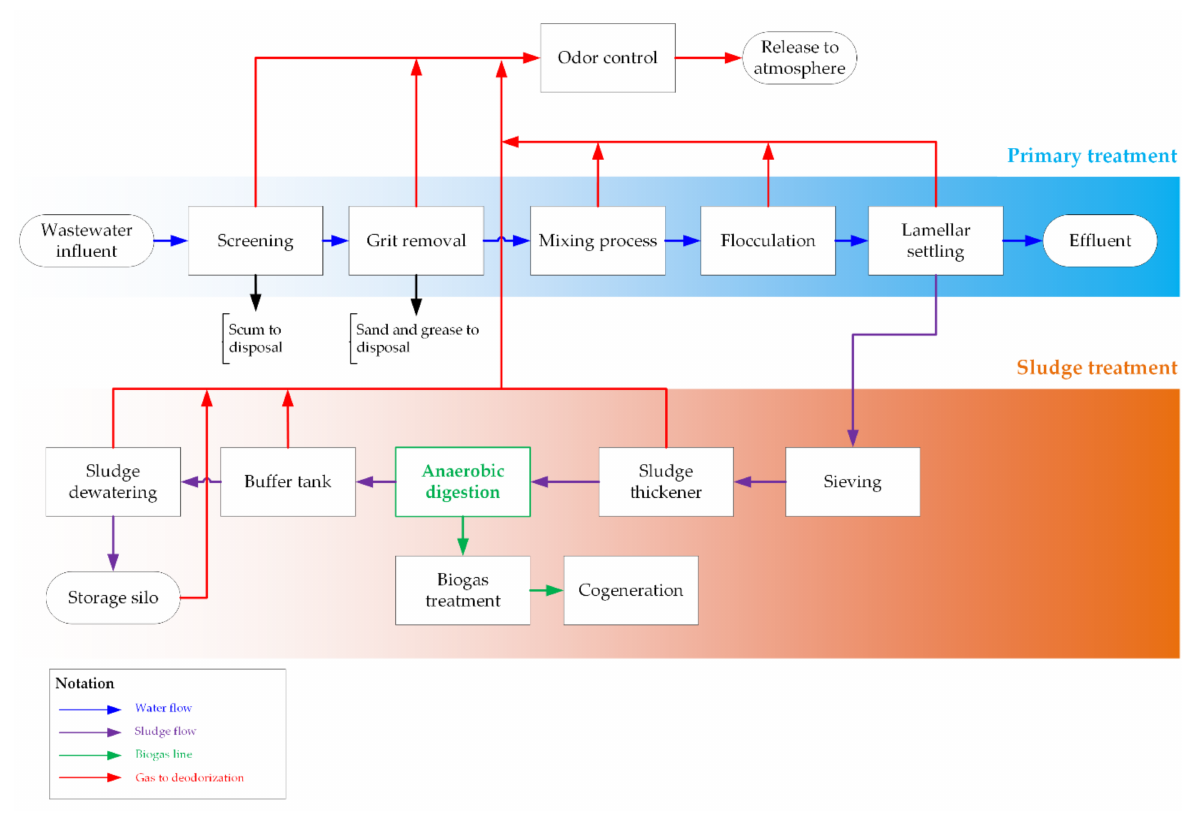
Figure 1. Wastewater treatment process diagram for the case study. Source: Own